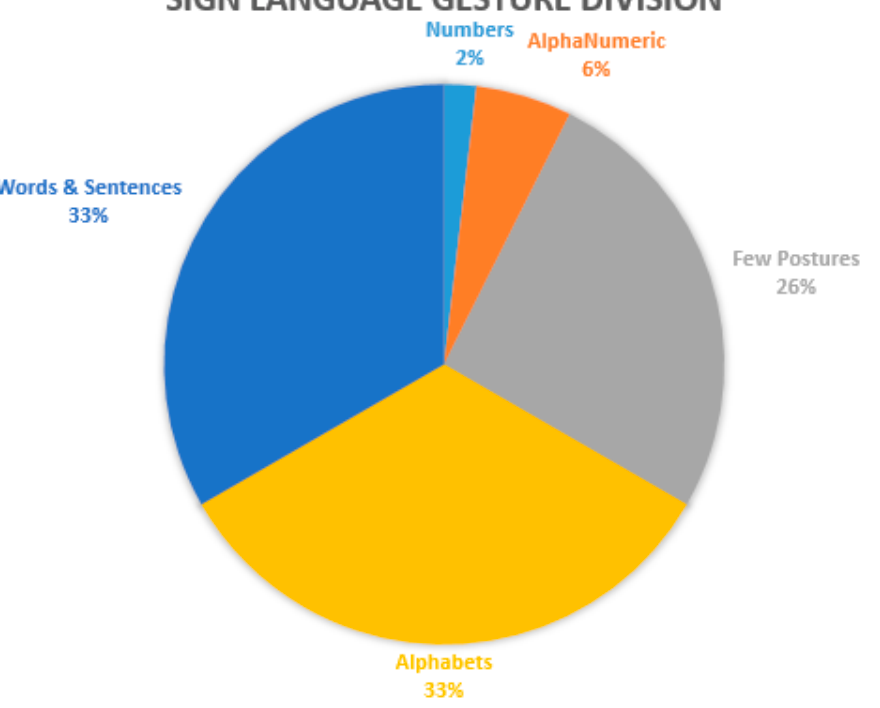
Figure 12. Number of articles on each variety of gestures.